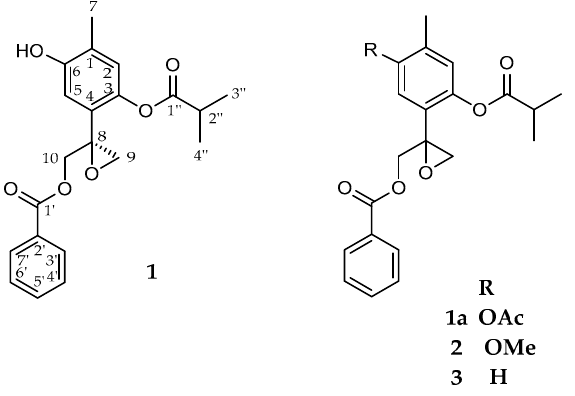
Figure 1. Chemical structure of 1 – 3 .